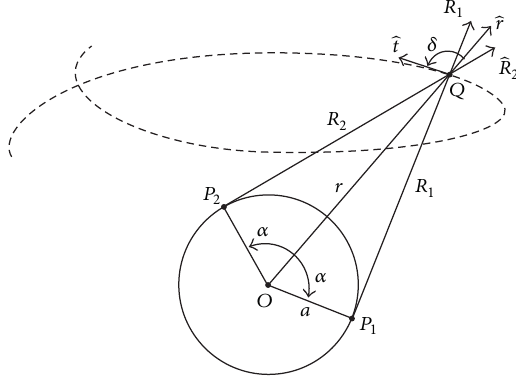
Figure 6: Geometry of the problem in the plane ̂𝑡, ̂𝑟